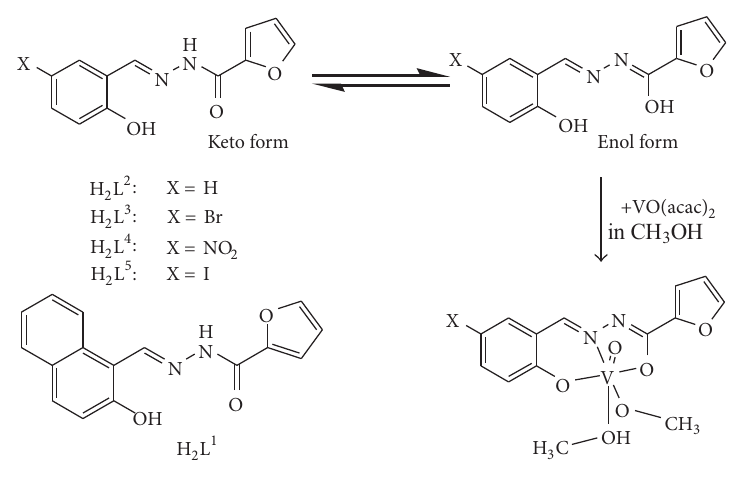
S 1: Tridentate hydrazone Schiff base ligands and their oxovanadium